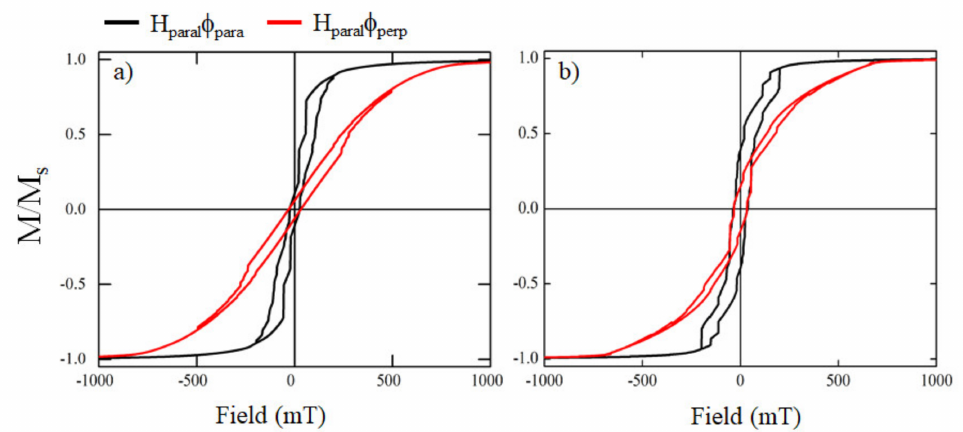
Figure A2. Hysteresis loops for an array of seven conical nanostructures with D 1 = 30 nm, D 2 = 52.5 nm, h = 55 nm, and center-to-center distance of 60 nm in the absence of magnetocrystalline anisotropy when a magnetic field is applied parallel ( H paral Φ paral , black line) and perpendicular ( H paral Φ perp , red line) to the y -axis of the system. ( a ) corresponds to the array without base and ( b ) corresponds to the array supported on a 4.5 nm thick iron base.